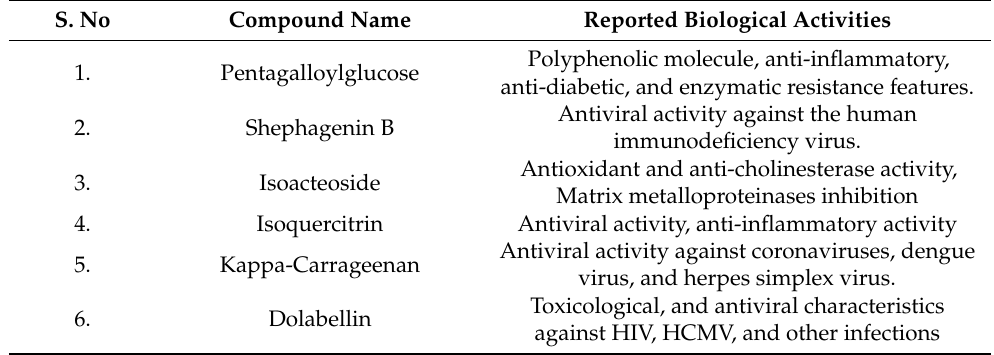
Table 2. The biological properties of six selected phytocompounds docked with the target M pro protein of